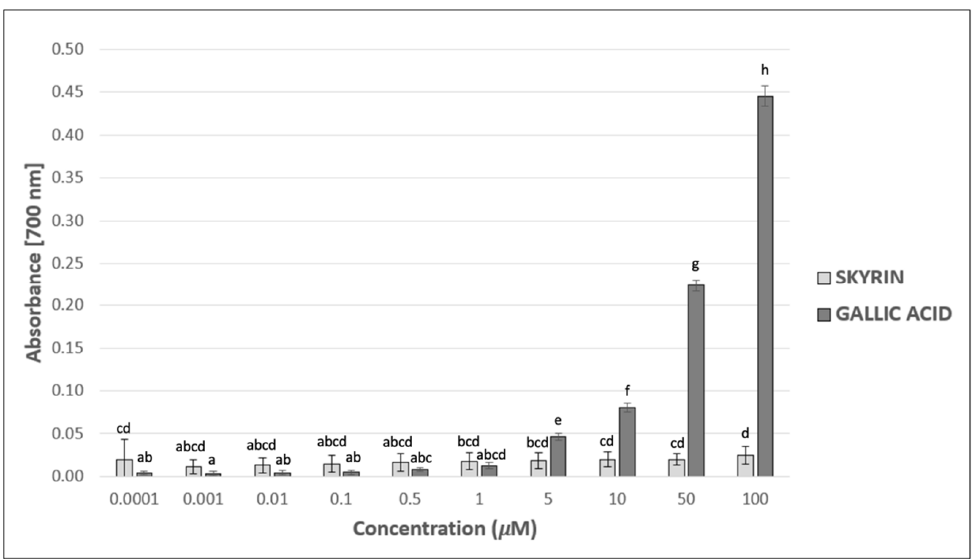
Figure 3. Reducing power of skyrin (light grey columns) in comparison with gallic acid used as a positive control at the same concentrations (dark grey columns). Each value is expressed as mean ± standard deviation. Results were analyzed by ANOVA single-step multiple comparisons of means using LSD tests, and comparisons between the mean values were considered significant at p < 0.05. Similar letters represent samples with no statistically significant differences between them. All the experimental data in this work are from at least three independent experiments.